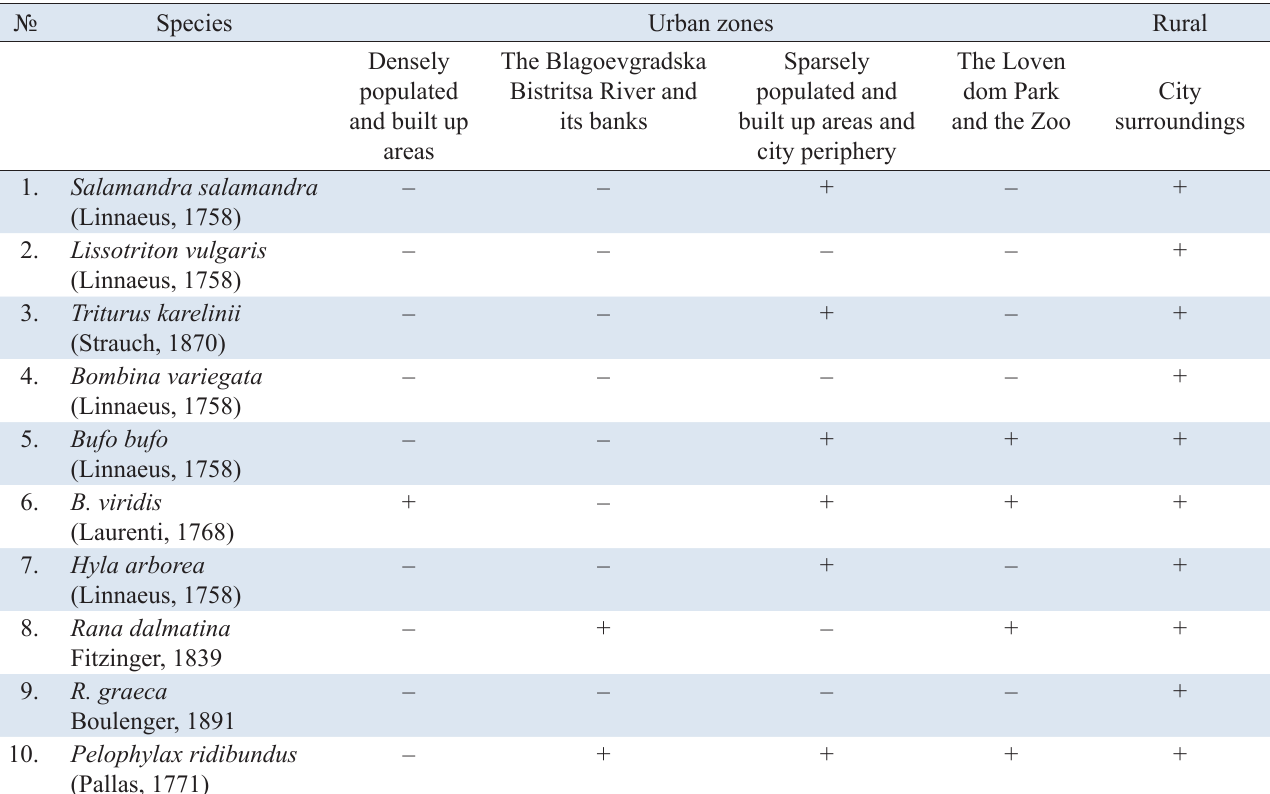
Table 1. Distribution of amphibians in the city of Blagoevgrad and its